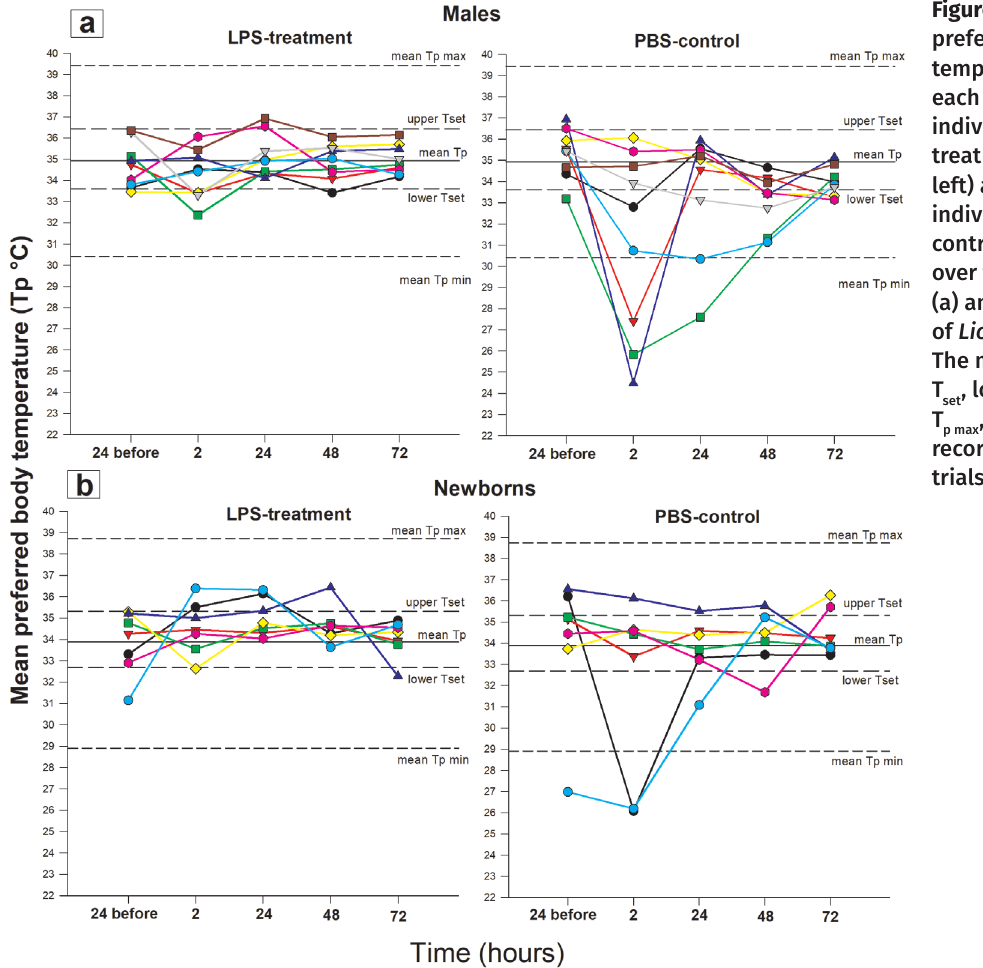
Figure 3. Mean preferred body temperatures (T ) of p each of the treated individuals (LPS, treatment; on the left) and control individuals (PBS, control; on the right) over time (h) for males (a) and newborns (b) of Liolaemus kingii . The mean T , upper p T , lower T , mean set set T , and mean T p max p min recorded before the trials are